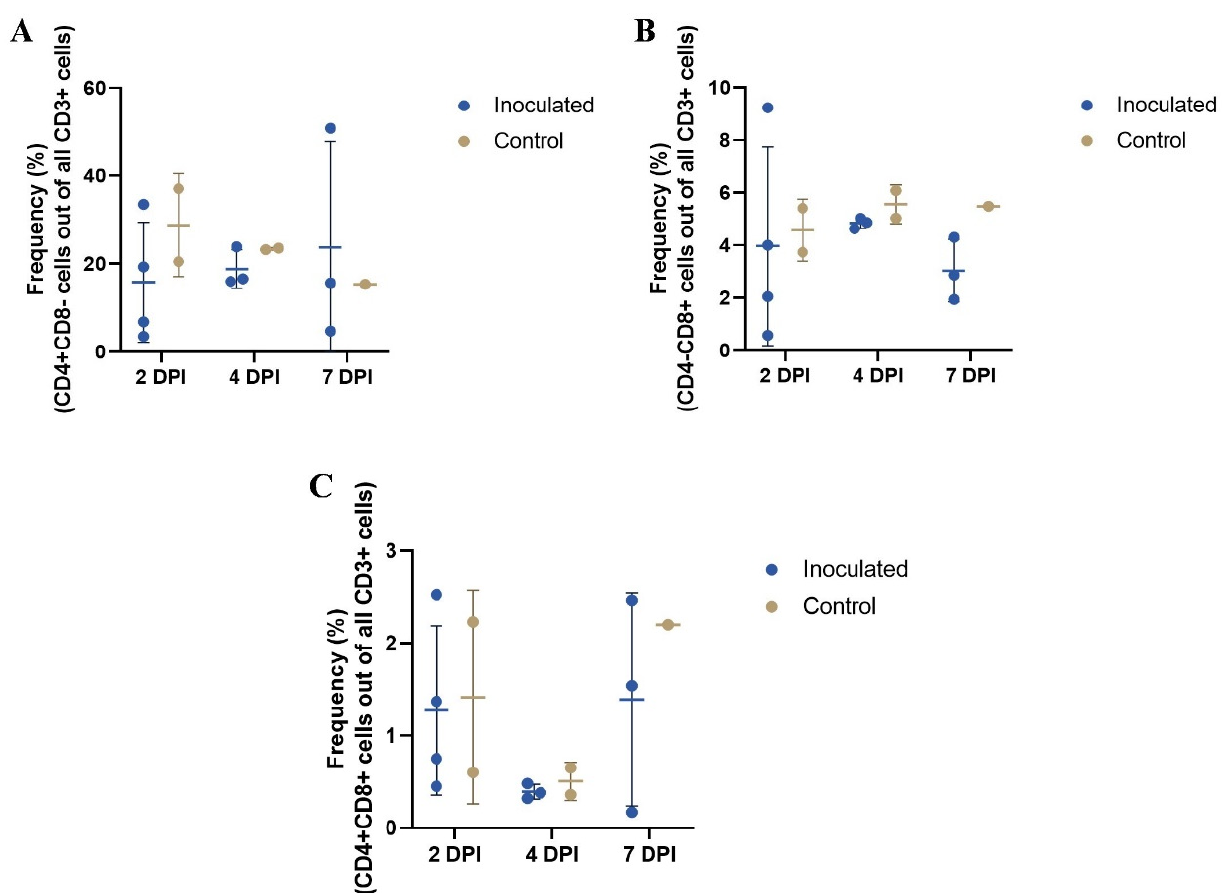
Figure 2. T cell frequencies in blood samples from the inoculated and the control group. A, B, and C show the frequencies of T cells at each day: CD4+CD8 − ( A ), CD4 − CD8+ ( B ), and CD4+CD8+ ( C ). The number of samples from inoculated and control animals was 4, 3, and 3, and 2, 2, and 1 at 2, 4, and 7 DPI, respectively. In the multiple unpaired T-tests performed on each cell type, there was no significant difference between the groups at 2, 4, or 7 DPI. The middle line and the bars indicate the mean ± SD. The figure was created with GraphPad Prism.